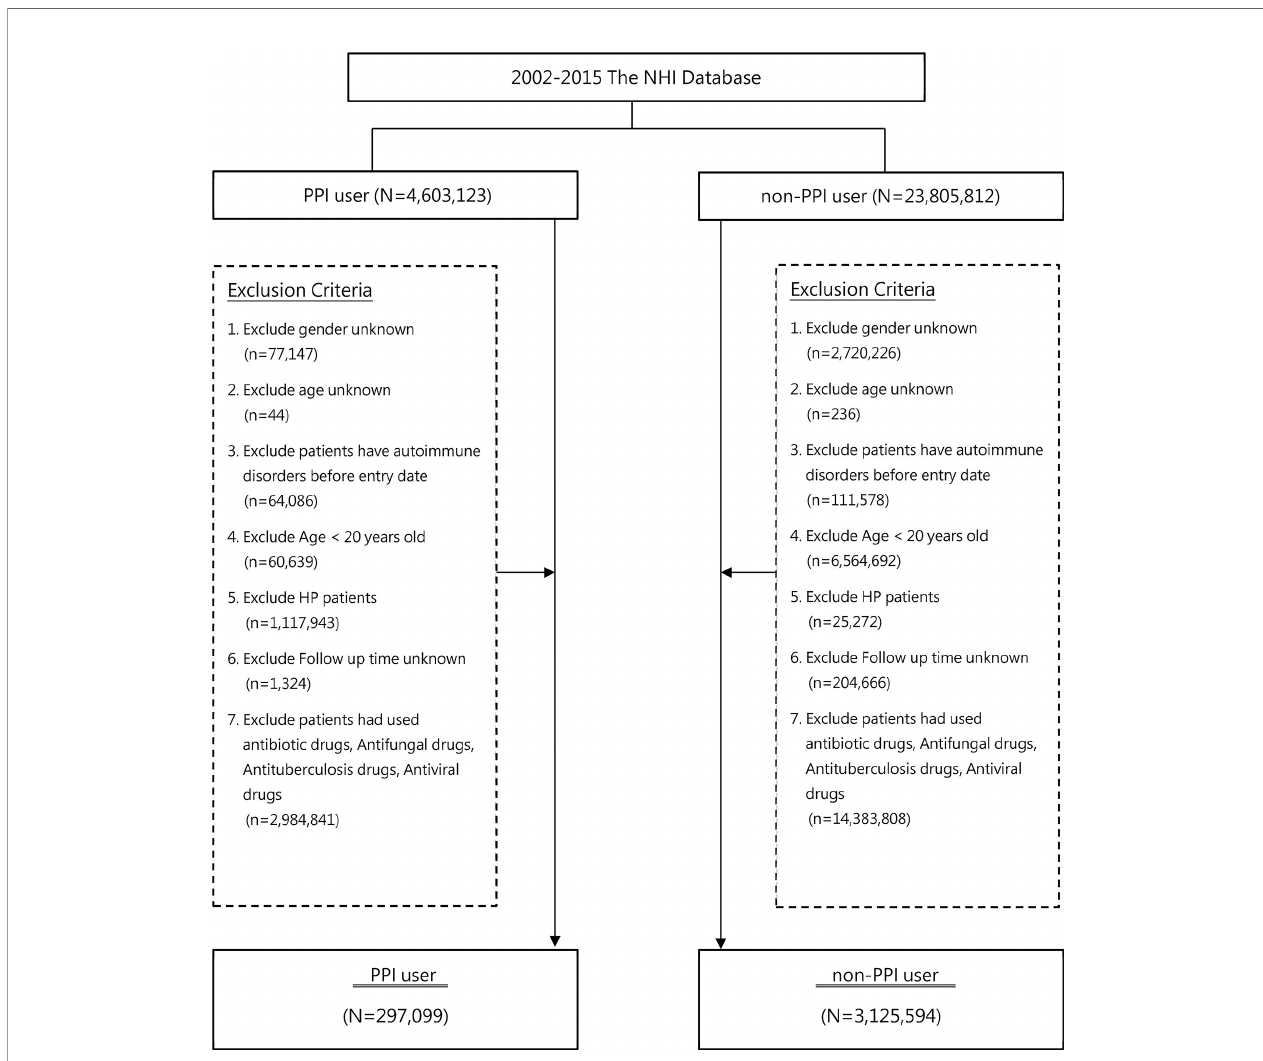
FIGURE 1 | Study fl ow chart. NHI, nation health insurance; PPI, proton pump